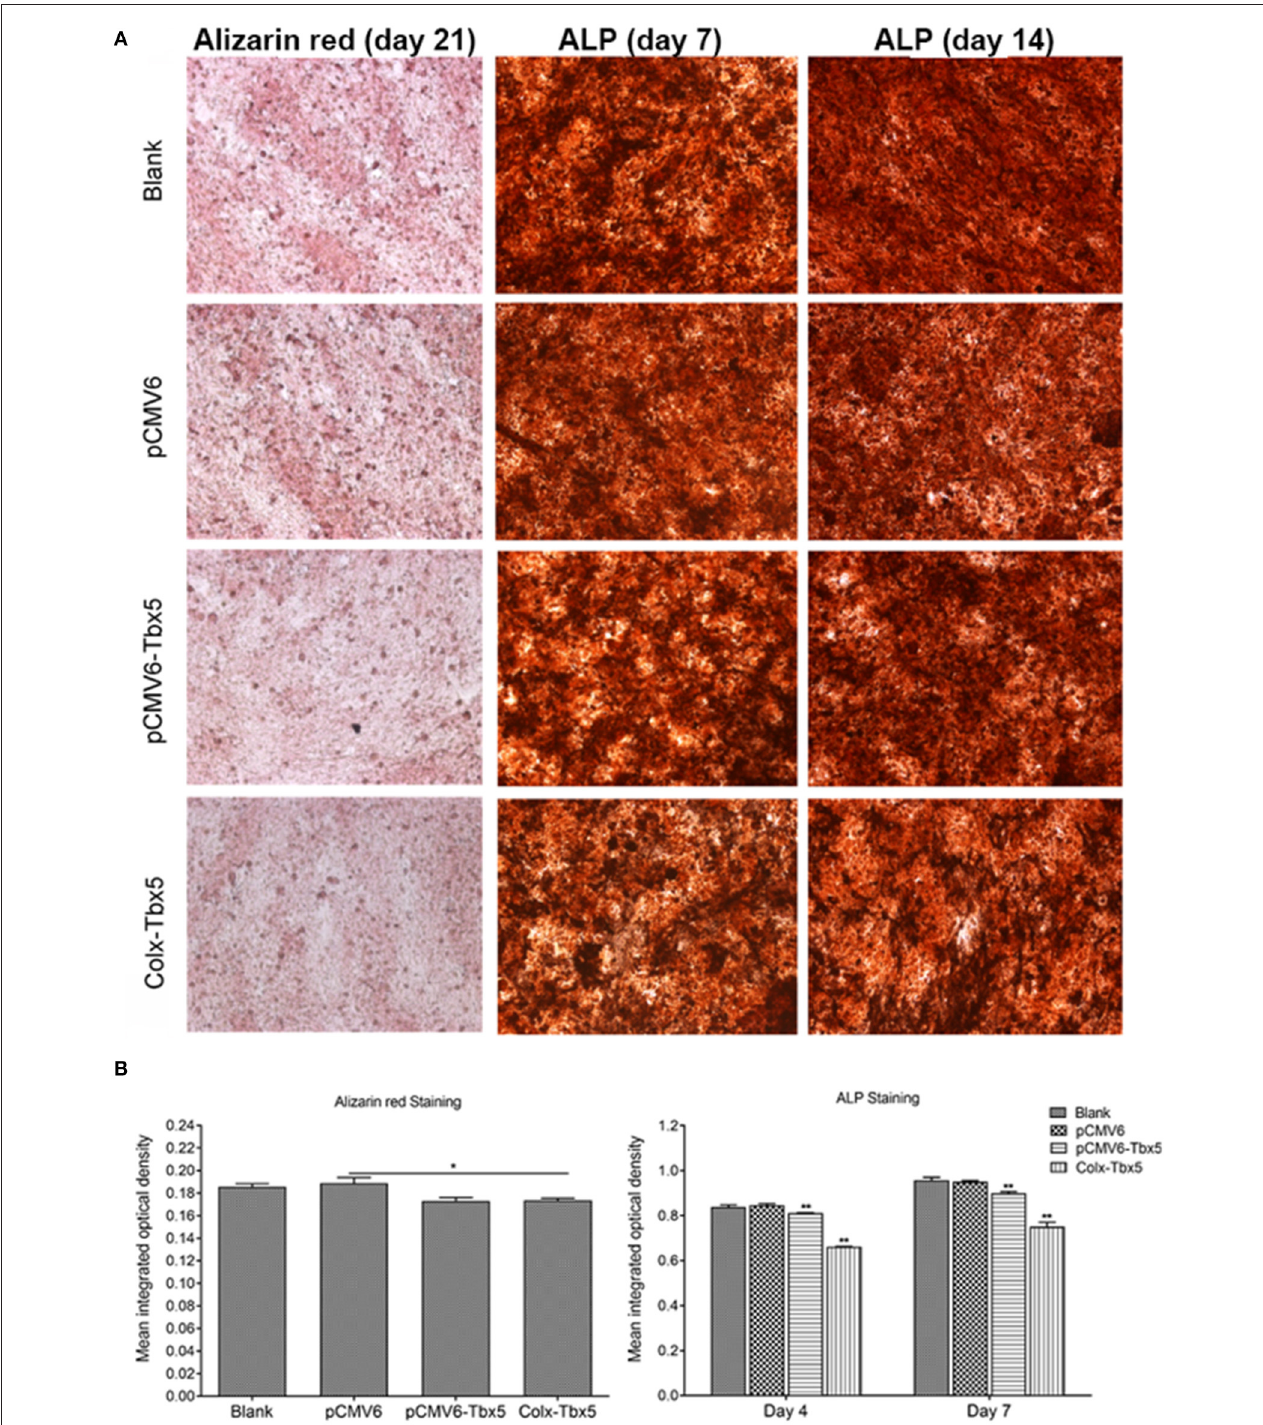
FIGURE 6 | Effects of Tbx5 on chondrogenic differentiation in ATDC5 cells. (A) Tbx5 -overexpressing cells showed slightly weaker Alizarin red staining than control cells on day 21 of culture. Tbx5 -overexpressing cells showed slightly weaker ALP staining on days 4 and 7. (B) Quantification of mean integrated optical density of Alizarin red and ALP staining in Tbx5 -overexpressing and control cells using Image-Pro Plus 6.0 image analysis software. Compared with control cells (blank, pCMV6 ), Tbx5 -overexpressing cells ( Tbx5 , ColX-Tbx5 ) showed slightly weaker Alizarin red staining (left). Tbx5 -overexpressing cells also showed slightly weaker ALP staining on days 4 and 7 (right). * p < 0.05, ** p <